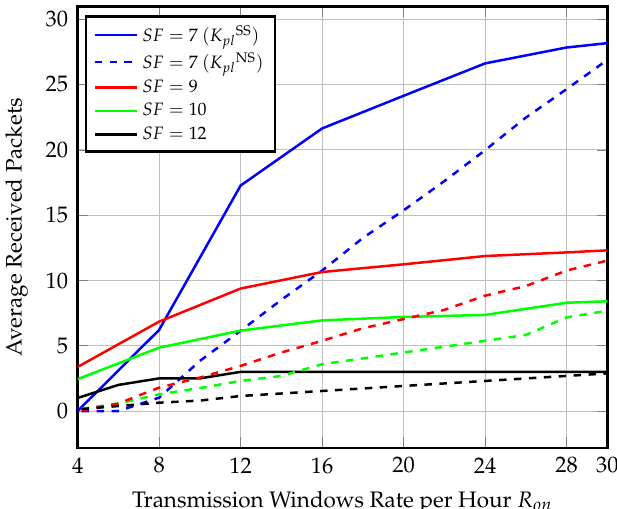
Figure 13. Average number of received packets of different SF and R on values at speed = 80 km/h and single gateway for nonsynchronized gateway arrival scenario.